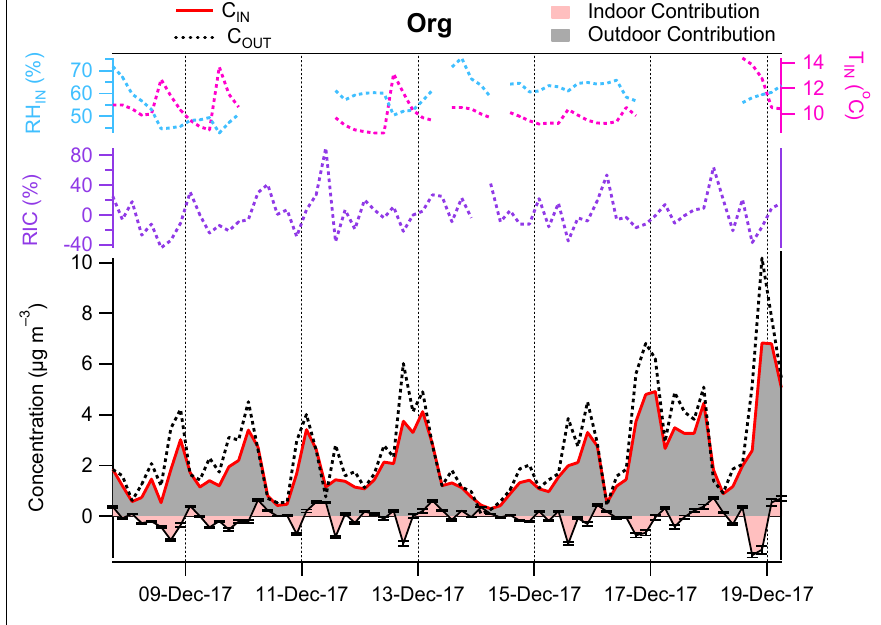
Figure 12. IC-OC contribution of Org. IC: − 0.03 µg m − 3 , RIC: 3%. Error bars represent 1 σ